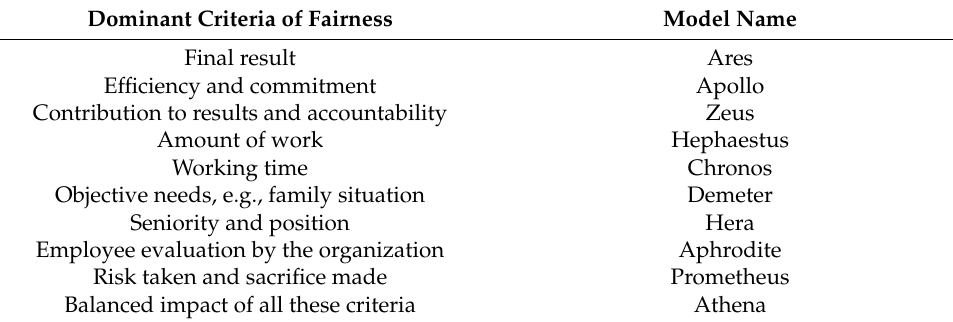
Table 1. Models of perceived justice by